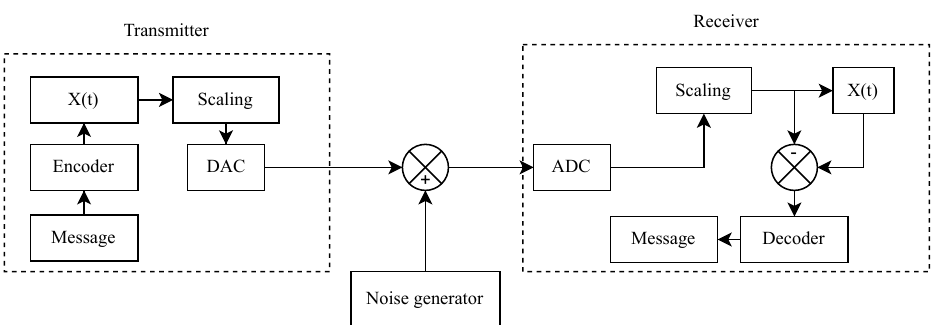
Figure 3. Block diagram of the designed chaotic communication